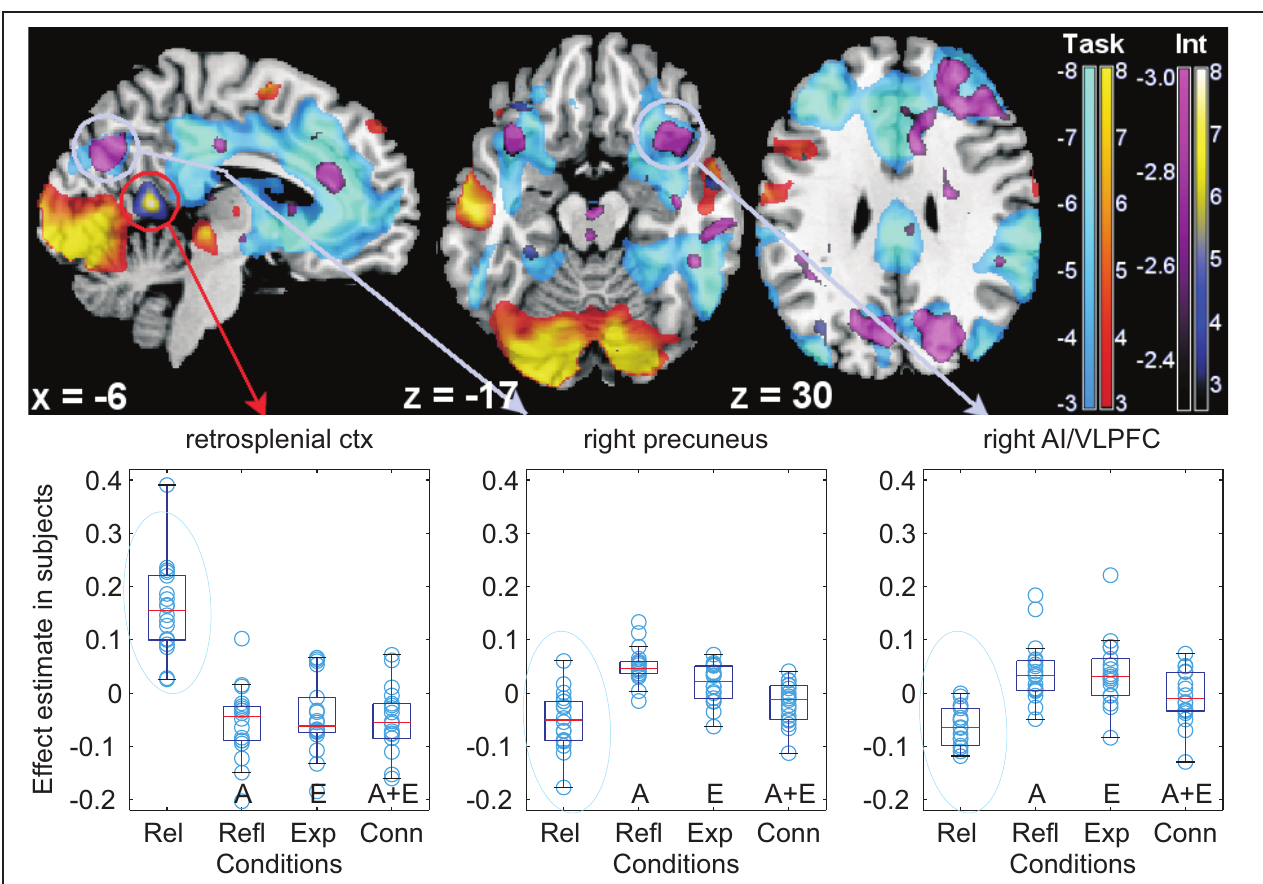
the regression on individual differences of Figure 3 , especially for the medial aspect of the brain on the left, and the orbitofrontal cortex. Bottom: box-plots of signal differences between conditions. The light blue circles highlight the textual version where neither abstract nor emotional words were used, and which drives the interaction. For an explanation of the symbols of the box-plots, see the legend of Figure 3 . AI/VLPFC: anterior insula/ventrolateral prefrontal cortex; ctx: cortex; Int: